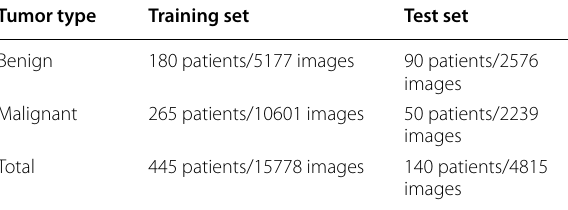
Table 1 The details of spinal tumor dataset